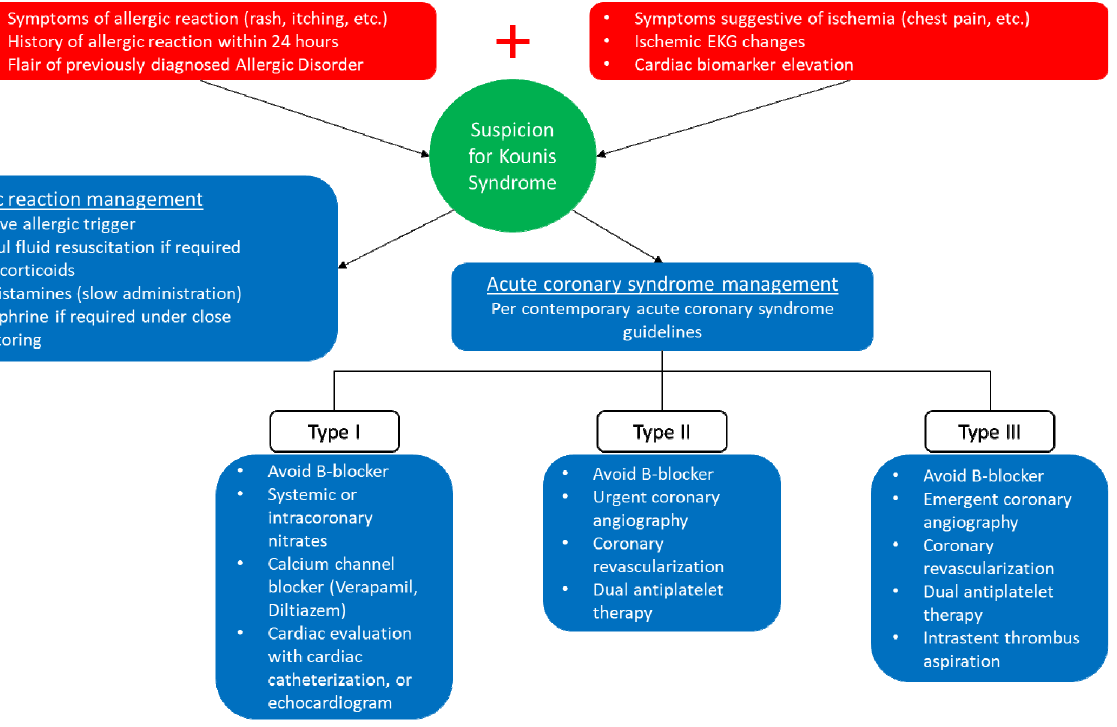
Figure 3. Suggested algorithm for Kounis syndrome